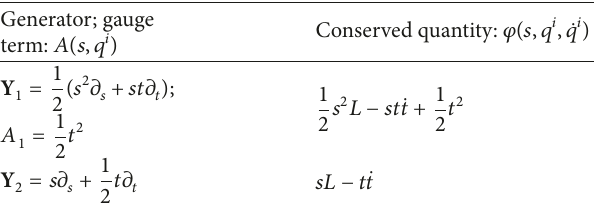
Table 42: Conserved quantities corresponding to each Noether symmetry.